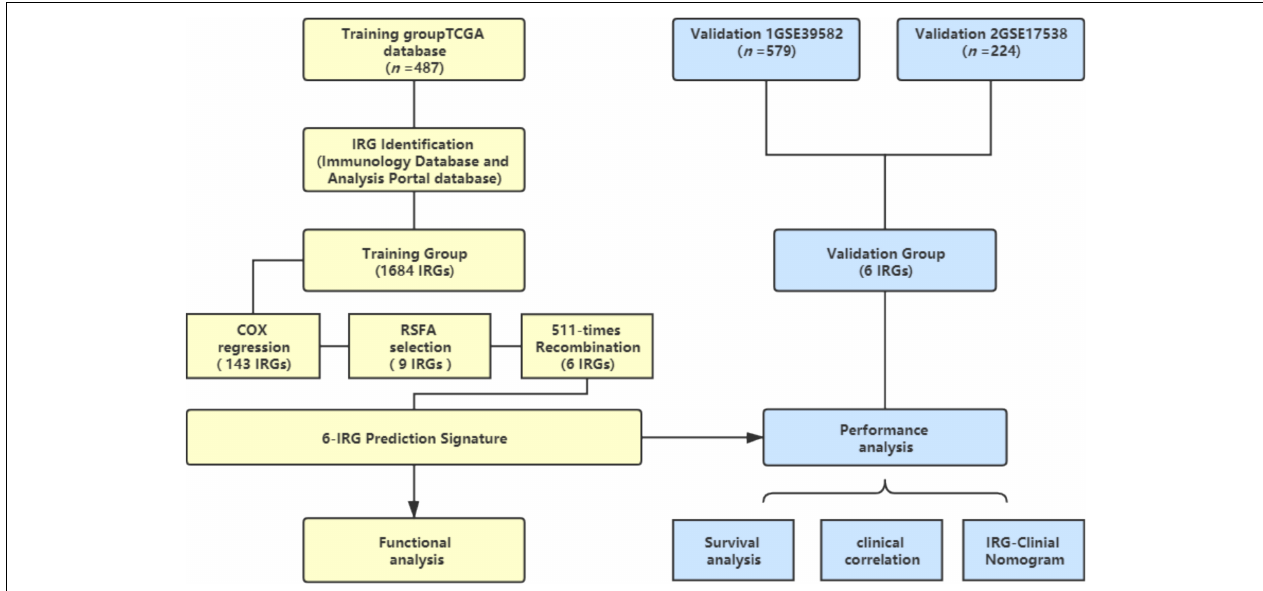
FIGURE 1 | Schematic of this study. Survival and relevant clinical information, along with IRG expression data, were acquired from an online database. The TCGA database ( n = 487) was used as the training group. An IRG prediction panel was developed via the aforementioned procedures and was tested for its function via GO and KEGG analyses. The model’s discrimination was assessed and validated in GSE39582 ( n = 578) and GSE17538 ( n = 224). TCGA, The Cancer Genome Atlas; IRG, Immune-related gene; RSFA, random survival forest